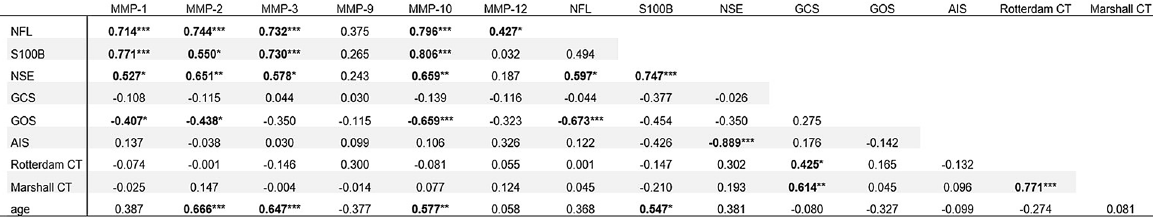
Figure 5. Correlation matrix between the CSF concentrations of MMPs and biomarker for brain injury and severity/outcome scores. The correlation matrix contains Spearman’s correlation coefficients (rho) between each variable. GOS is used as an ordinal scale (GOS = 1–5) in correlation matrix. Statistical significance: *p ≤ 0.05, **p ≤ 0.01, ***p ≤ 0.001. AIS abbreviated injury scale, CT computerized tomography, GCS Glasgow Coma